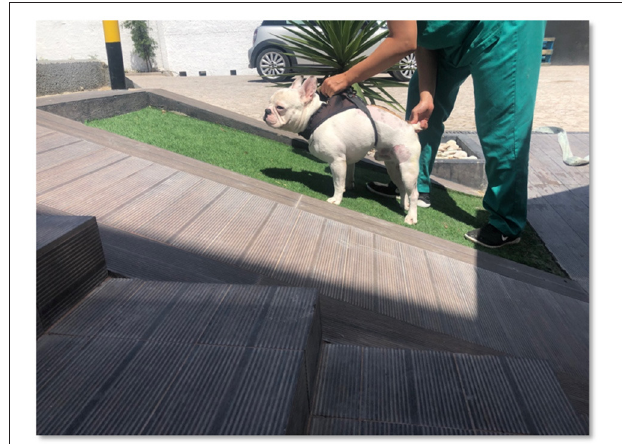
FIGURE 8 | Gait Stimulation on uneven floor, such as ramp up and down.